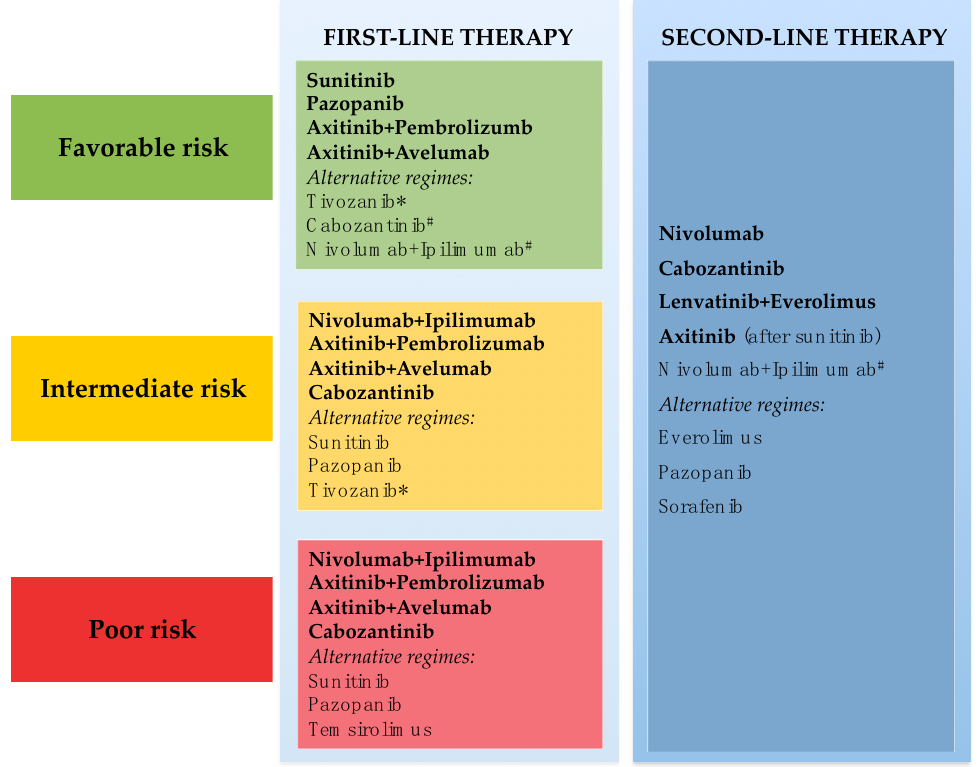
Figure 2. Systemic treatment of clear-cell renal cell carcinoma according to IMDC prognostic system. * Only EMA approval, # Only FDA approval.